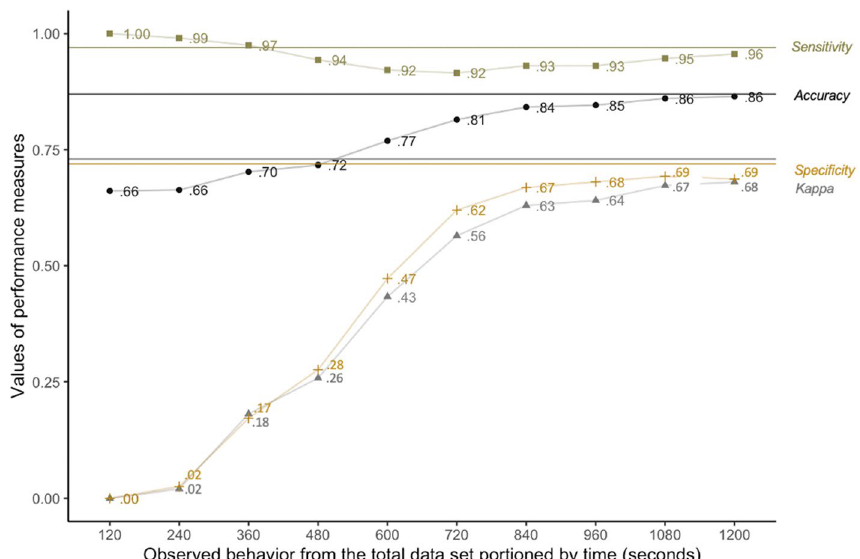
Fig. 3 Performance Measures for the Random Forest Model Applied to Increasing Amounts of Data. The horizontal lines represent the final values for the RF algorithm based on the original complete data